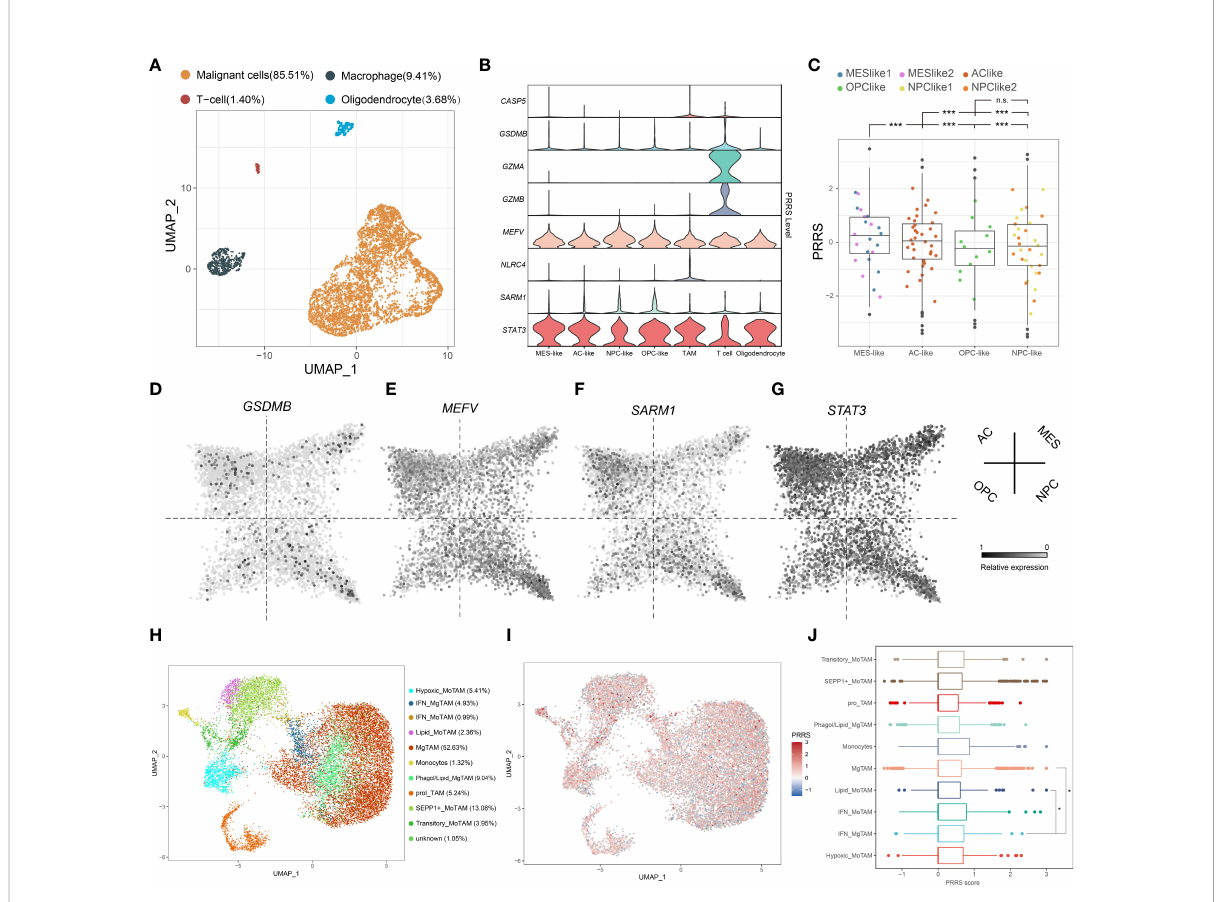
FIGURE 7 PRRS genes are expressed at a cell type-speci fi c manner. (A) UMAP plot of malignant cells and immune cells was performed on TPM- normalized data. (B) Expression pattern of PRRS gene in different cell type. (C) PRRS value in different subtype of GBM cells. (D-G) Expression pattern of GSDMB , MEFV , SARM1 , and STAT3 in different subtype of GBM cells. (H) UMAP plot of TAMs was performed on RPCA-based integrated data. (I) PRRS value was calculated in different subtype of TAMs. TAMs, tumor-associated macrophages/microglia. MoTAM, monocyte-derived TAM; MgTAM, microglia-derived TAM. *P < 0.05; ***P < 0.001, n.s., not signi fi